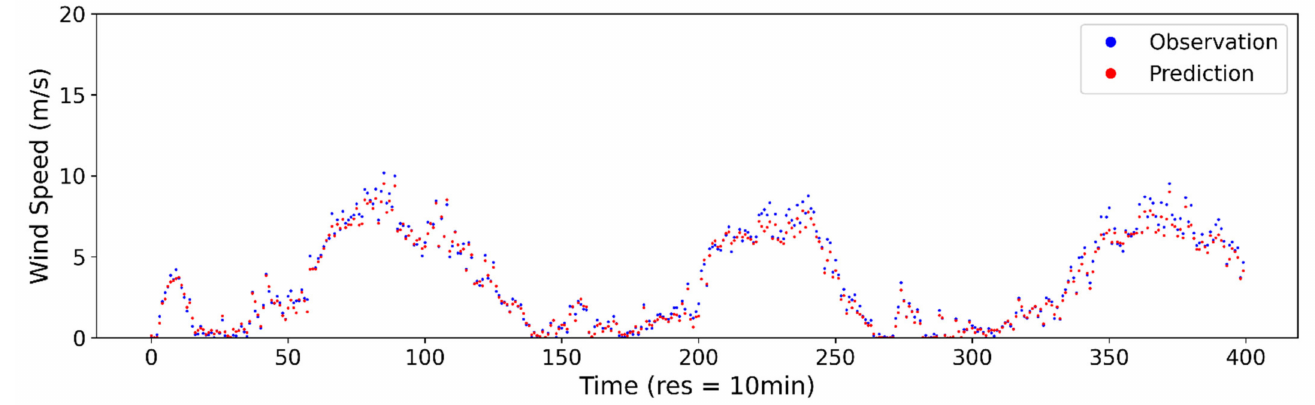
Figure A5. Estimated vs. observed wind speed at 10-min sampling interval using ANN model.